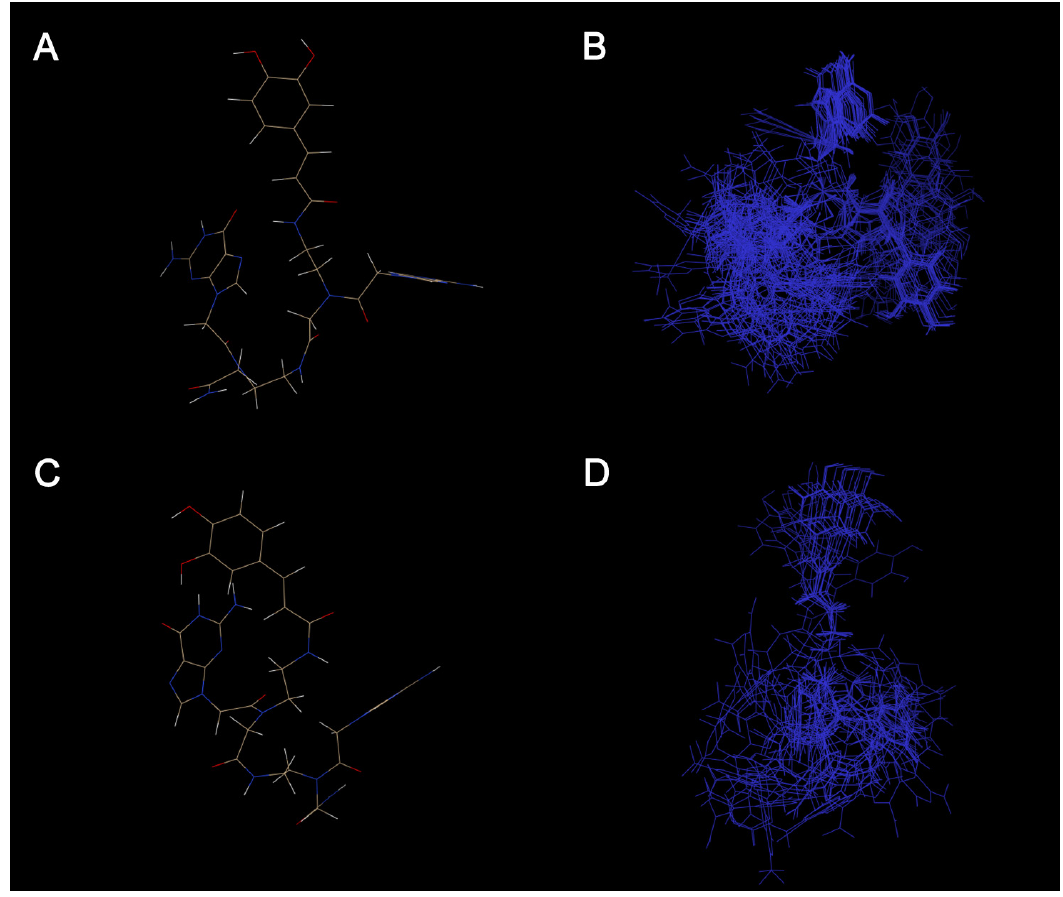
Figure 7. The proposed molecular structure of the compound 1 ( A ) and compound 2 ( C ). Structure ensemble of the conformations generated and selected by Cyndi for compound 1 ( B ) and compound 2 ( D